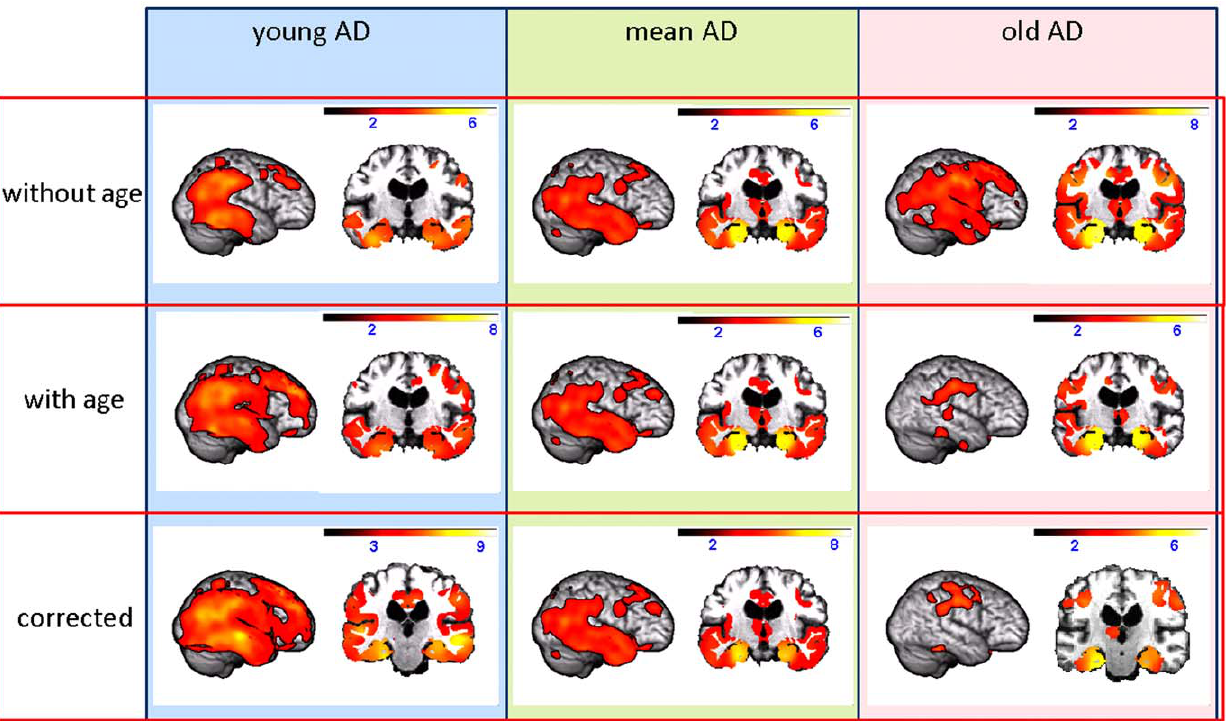
Figure 3. Visualization of VBM results for different age groups. GM atrophy projected onto an averaged brain detected with VBM in three groups of AD patients (columns) differing in age compared to the same group of healthy control subjects without age as covariate (upper row), with age as covariate (middle row) and after the proposed age correction (lower row). Color bars indicate the t-values. Images are thresholded with p=0.001 on voxel level (uncorrected) and p=0.05 on cluster level (FWE corrected). AD Alzheimer’s disease, VBM voxel-based morphometry. Anatomical convention. Radiological convention.